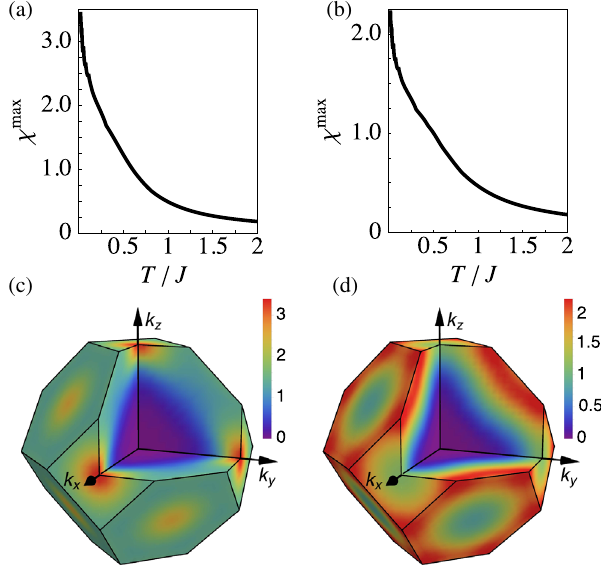
FIG. 17. The RG flow of the dominant susceptibility (in units of 1 =J ) inside the paramagnetic regime of the S ¼ 1 = 2 J shown for (a) J 2 =J 1 ¼ 0 . 1 , (b) J 2 =J 1 ¼ − 0 . 1 [marked by black circles in Fig. 16(a)], and (c),(d) their respective spin suscep- tibility profiles evaluated at the lowest simulated temperature T=J ¼ 1 = 100